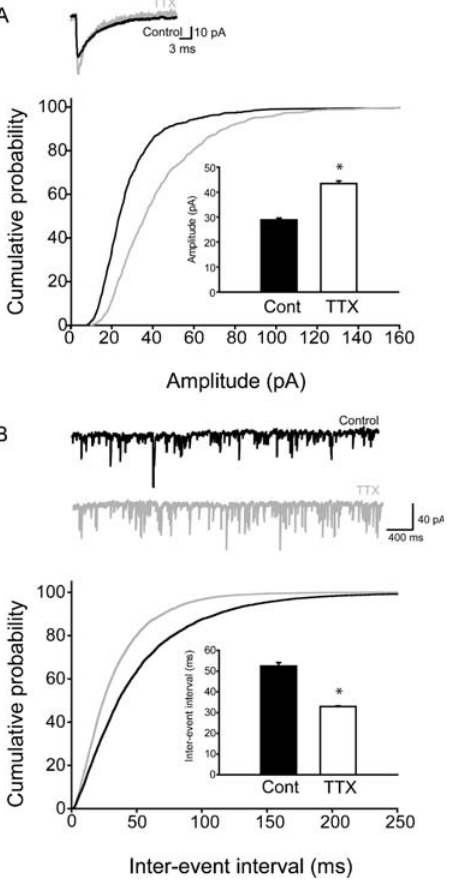
Figure 4. Increased amplitude and frequency of mIPSCs in adult CA1 cells after in vivo TTX-application. (A) Summary data of the mIPSC amplitudes (for numbers of cells and animals, see main text); insert: representative averages from single cells. (B) Summary data of the inter- event interval of mIPSCs, with representative traces. doi:10.1371/journal.pone.0000700.g004 cells, 5 animals; TTX: n=11cells, 6 animals), or kinetics (Table 1).